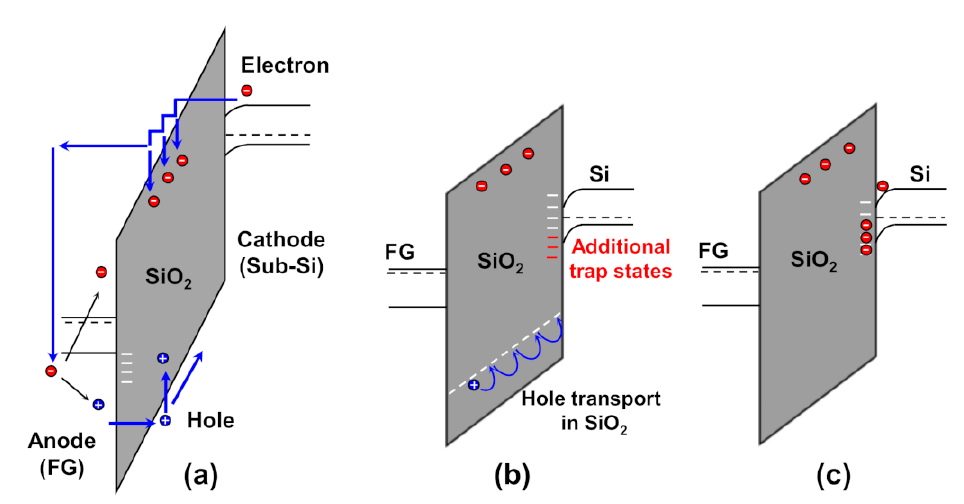
Figure 19. ( a ) Schematic diagram of anode hole injection during P/E cycles. During E-to-P t wait , Q T is generated via two possible physical mechanisms: ( b ) the holes migrate toward the silicon/oxide interface and recombine with inversion electrons, creating additional trap states. ( c ) Subsequently, electrons are trapped in these trap states. Reprinted from